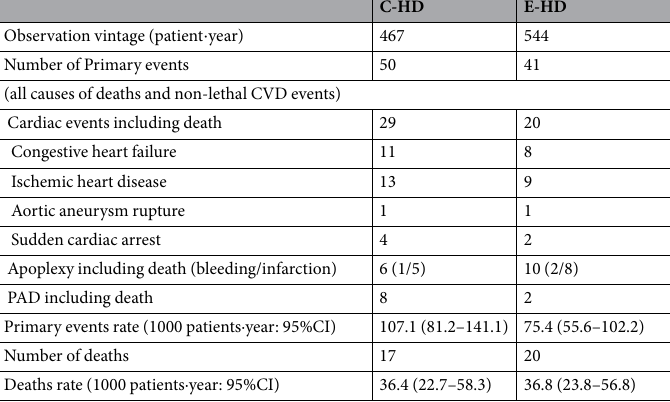
Table 3. Summary of events in the two groups. C-HD, conventional haemodialysis; E-HD, electrolyzed water haemodialysis. PAD, peripheral artery disease (with surgical procedure).